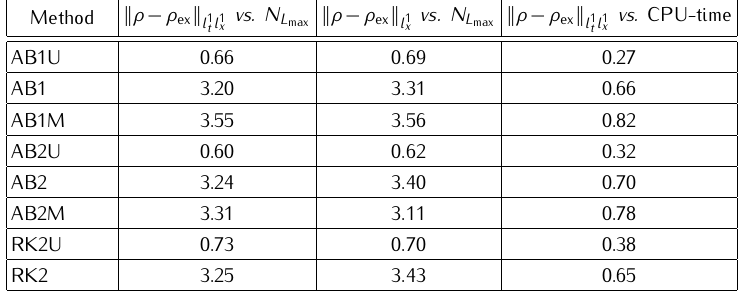
Table 2. Numerical order on the density error using the l 1 the l 1 t l 1 x -norm on the density error with respect to the CPU-time (in the log 10